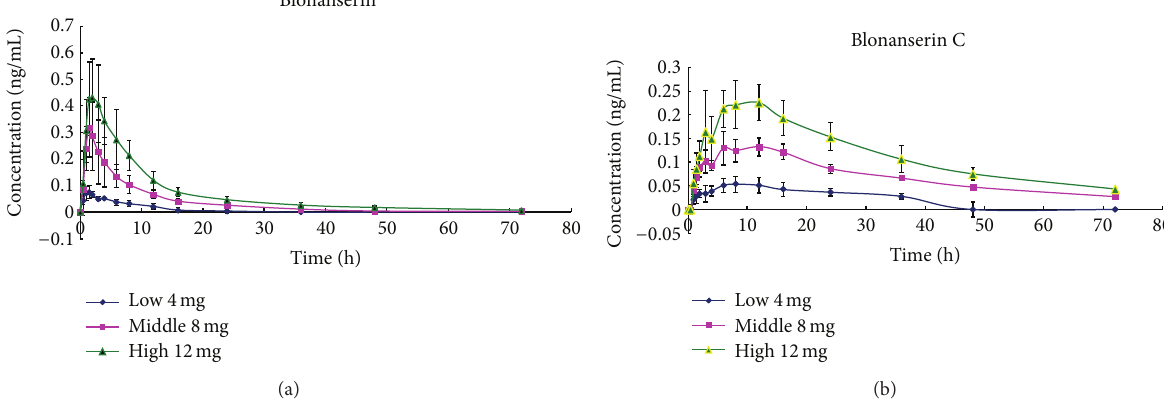
Figure 3: Mean plasma concentration-time profile of blonanserin and blonanserin C after oral administration of blonanserin tablets (low, 4 mg, middle, 8mg, and high, 12mg) to 6 healthy subjects. Table 4: Mean pharmacokinetic parameters for blonanserin and blonanserin C (𝑛 = 6 ).